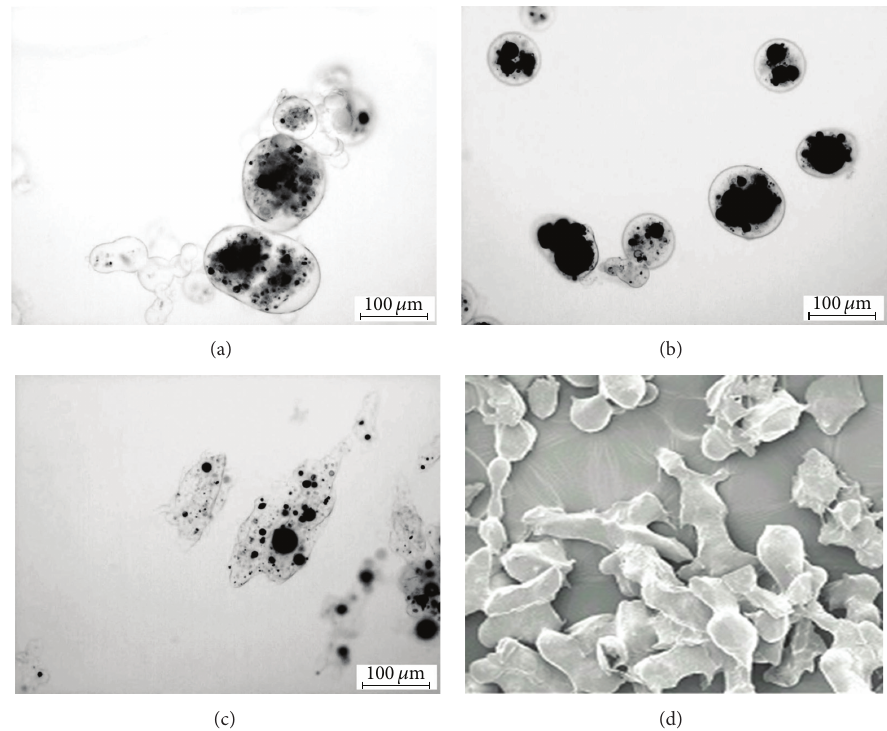
Figure 1: Micrographs obtained with the optical microscope (a, b, c) and scanning electronic microscope (d) of the lycopene microcapsules: (a, d) formulation 1 (E2.5/C25), (b) formulation 4 (E5.0/C25), and (c) formulation 7 (E7.5/C25).